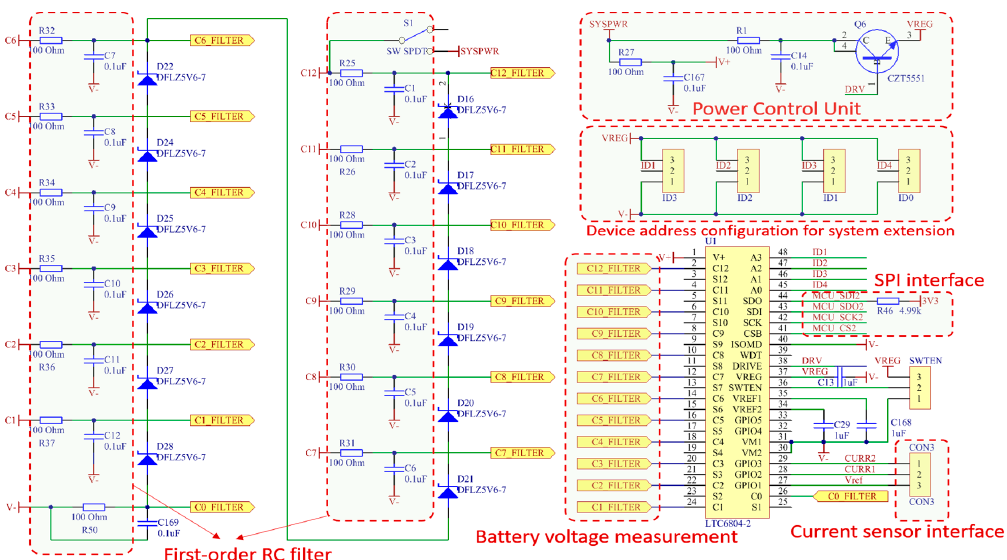
Figure 2. Hardware configuration of data-acquisition module of battery cells (RC: resistor capacitor, SPI: Serial Peripheral Interface).